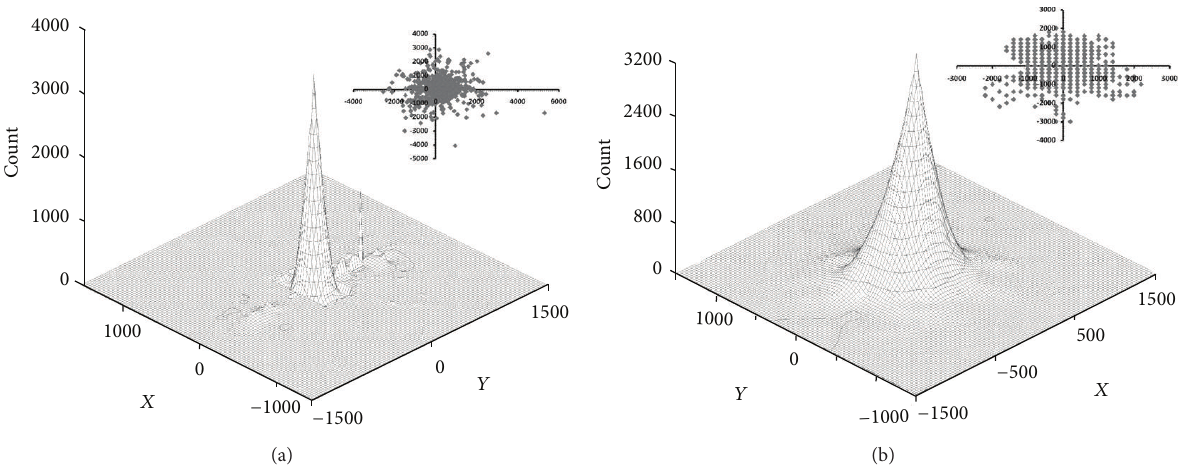
Figure 2: Distribution of spatial positions relative to home range center (m) for (a) observed and (b) simulated red grouper, aggregated across all individuals. Insets show two-dimensional distribution of position fixes. Simulation output is shown for movements corresponding to empirical sample